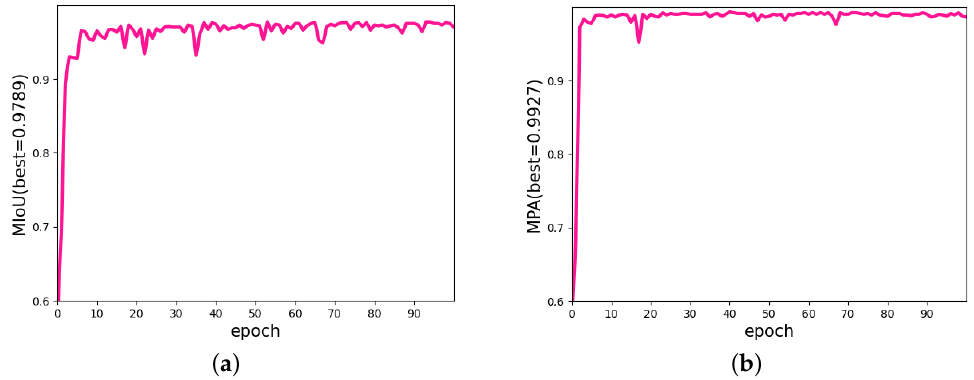
Figure 11. The metrics of the U-Net change curve. ( a ) The curve of the change in MIoU. ( b ) The curve of the change in MPA.